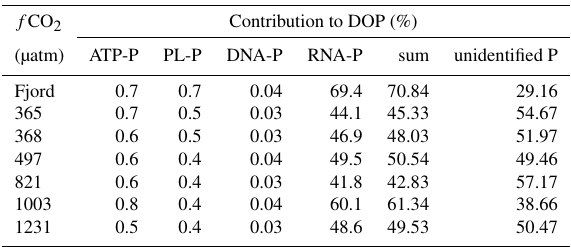
Table 3. Contribution of different phosphorus components to DOP in the mesocosms and in the fjord. f CO